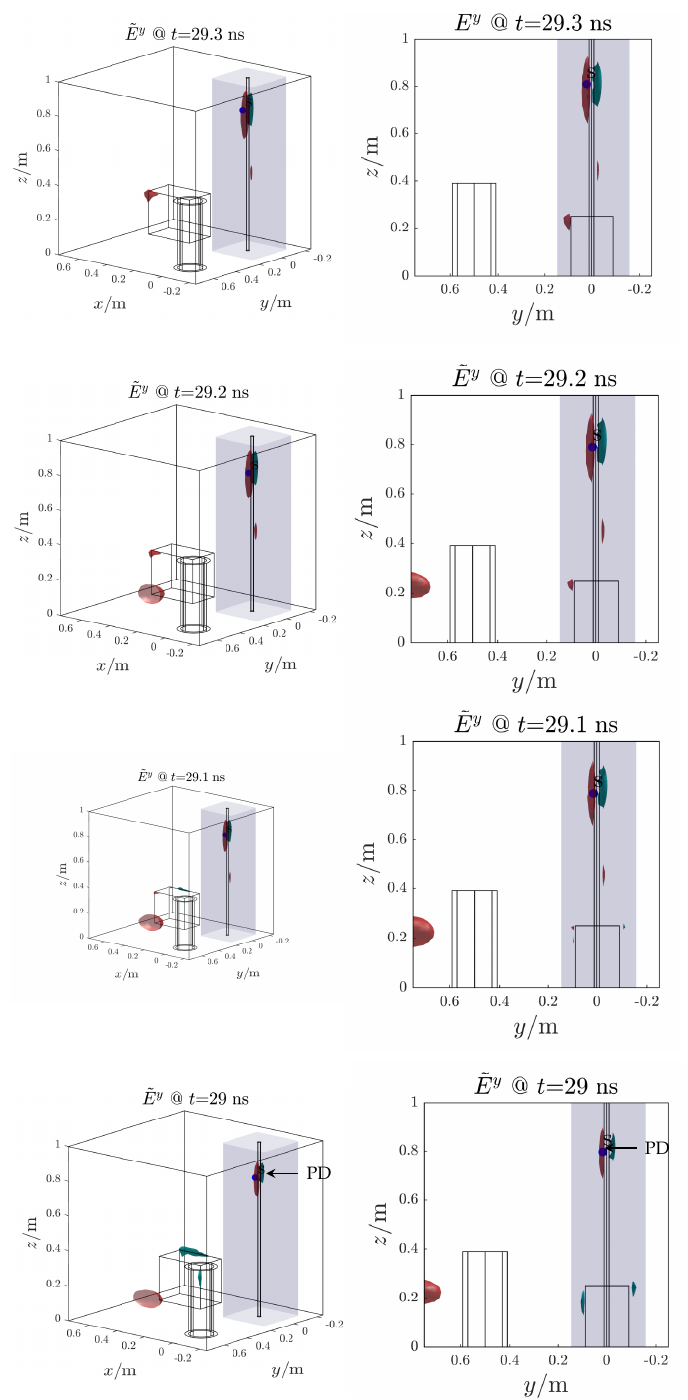
Figure 19. Test case 2. Reconstructed electric field distribution (propagation backward in time). The PD source ( s , blue dot) is correctly localized. The volume around the cable is blue highlighted.